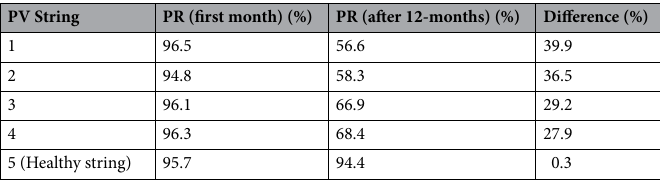
Table 1. Comparative analysis of the PV strings PR.